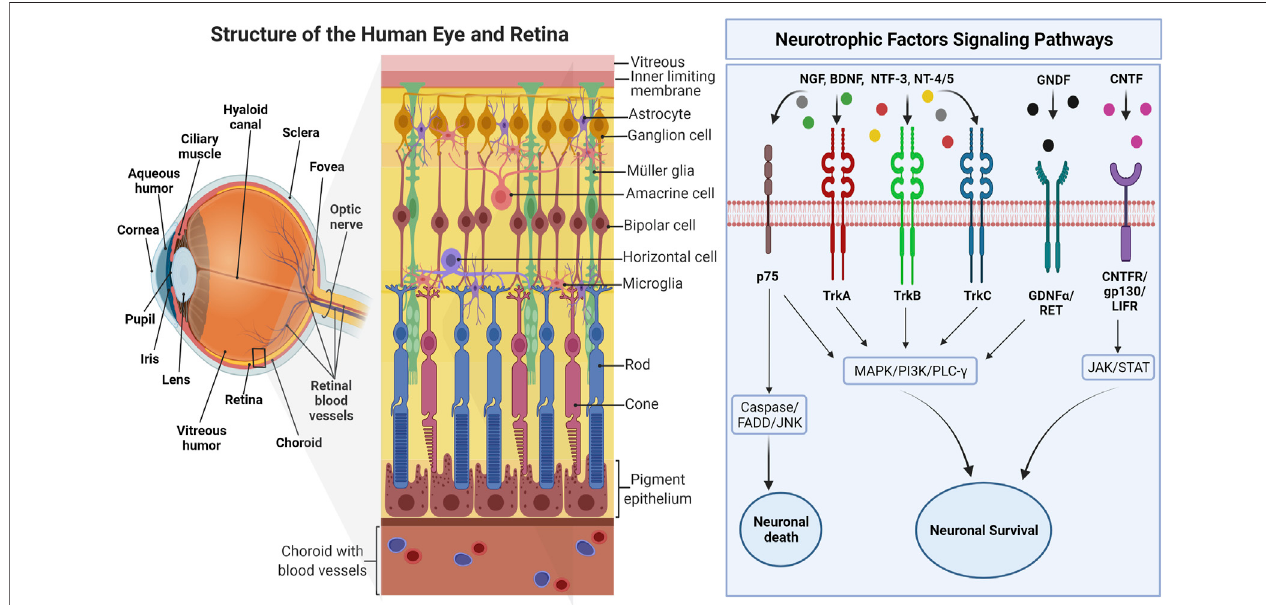
FIGURE 1 | The overview of human eye anatomy with focus on the retinal structure. The right side of the fi gure depicts the interactions of various NTFs with major intracellular signaling pathways activated through corresponding receptors. Adapted from “ Structure of The Retina ” by BioRender.com (2022). Retrieved from https://